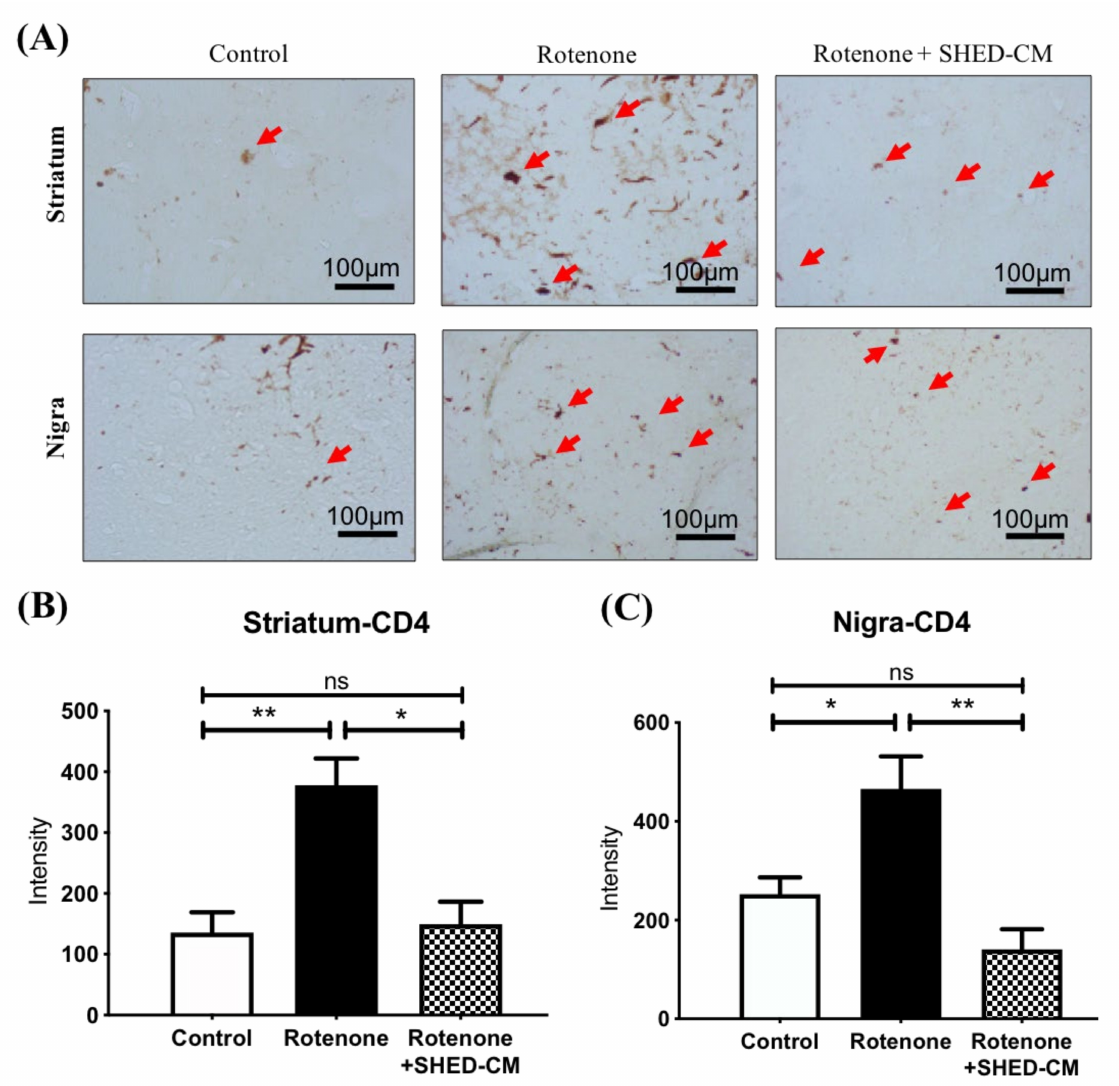
Figure 4. SHED-CM reduced CD4-positive T-cell migration in rotenone-induced PD rats. ( A ) Immunochemistry staining of CD4-positive T cells in striatum and substantia nigra from control rats or rotenone-induced PD rats with indicated treatment. ( B ) Statistic analysis of CD4-positive T cells in the striatum area revealed a significant reduction in the SHED-CM treatment group. ( C ) Statistic analysis of CD4-positive T cells in the substantia nigra area revealed a significant reduction in the SHED-CM treatment group. The red arrows indicate stained cells. Each group n = 3, * p < 0.05, ** p < 0.01, ns: no significant